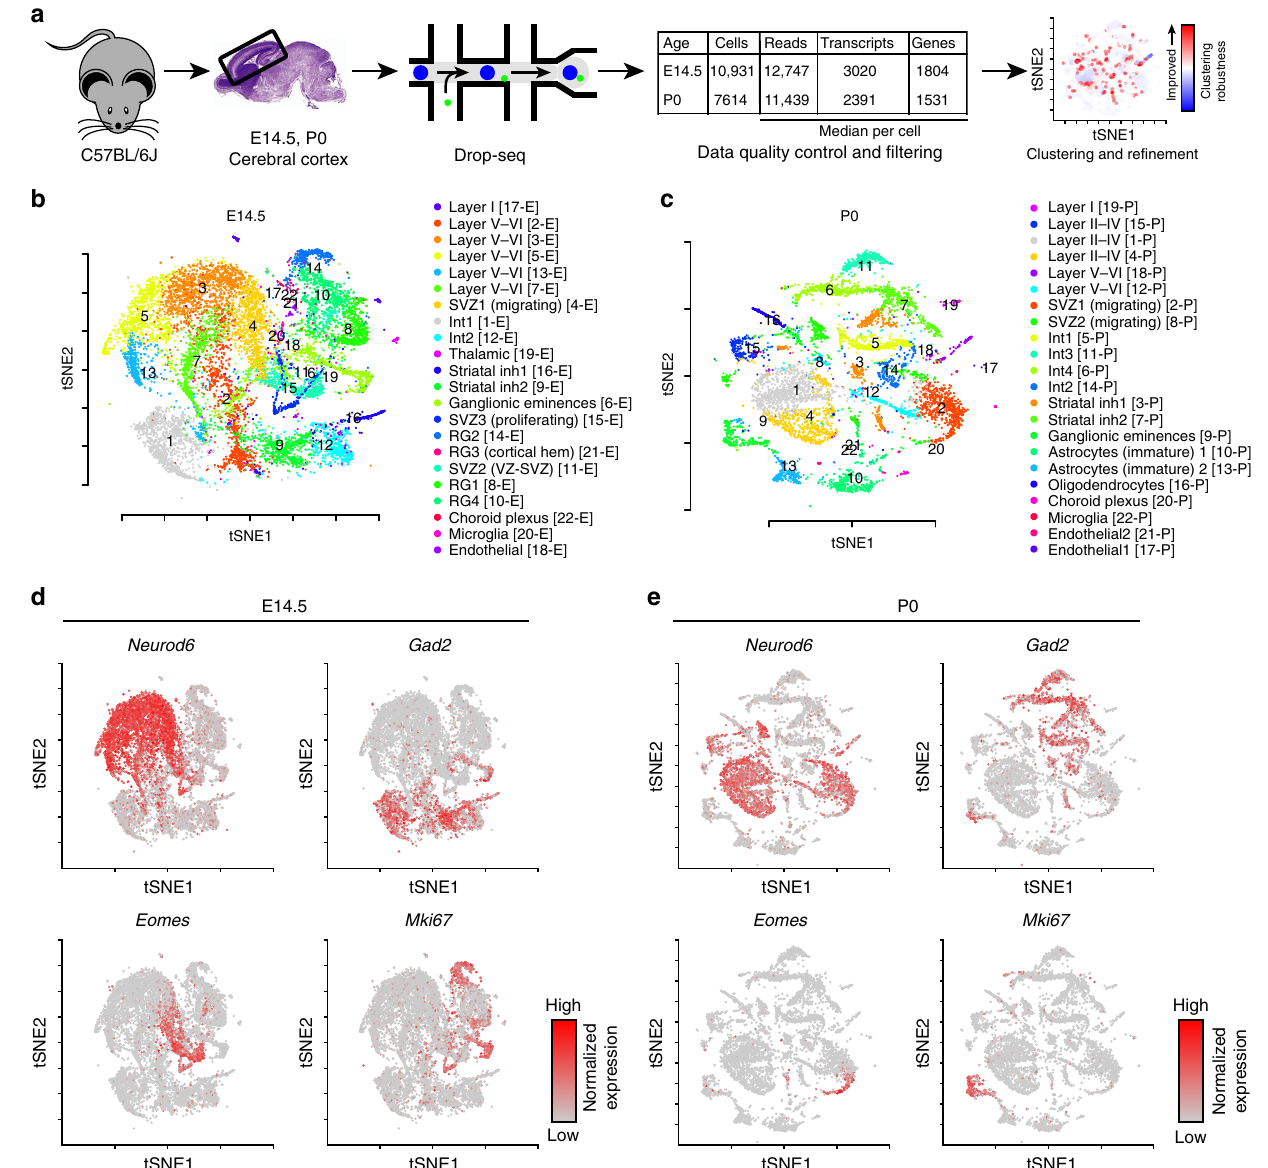
Fig. 1 Overview of the experimental approach and cell cluster analyses. a Cortical cells were isolated from E14.5 and P0 C57BL/6J mice across multiple biological replicates ( n = 6, E14.5; n = 3, P0). A novel iterative clustering framework was used to identify and re fi ne cell types, which improved the cluster robustness of most cells. b t-SNE visualization of the 22 clusters identi fi ed in the E14.5 cortex. c t-SNE visualization of the 22 clusters identi fi ed in the P0 cortex. d Visualization of E14.5 cells and e P0 cells overlaid with gene expression information of canonical marker genes, Neurod6 (excitatory neuron), Gad2 (interneuron), Eomes ( Tbr2 , neuronal progenitors), and Mki67 (proliferating and glia). The expression is depicted from gray (low) to red (high)